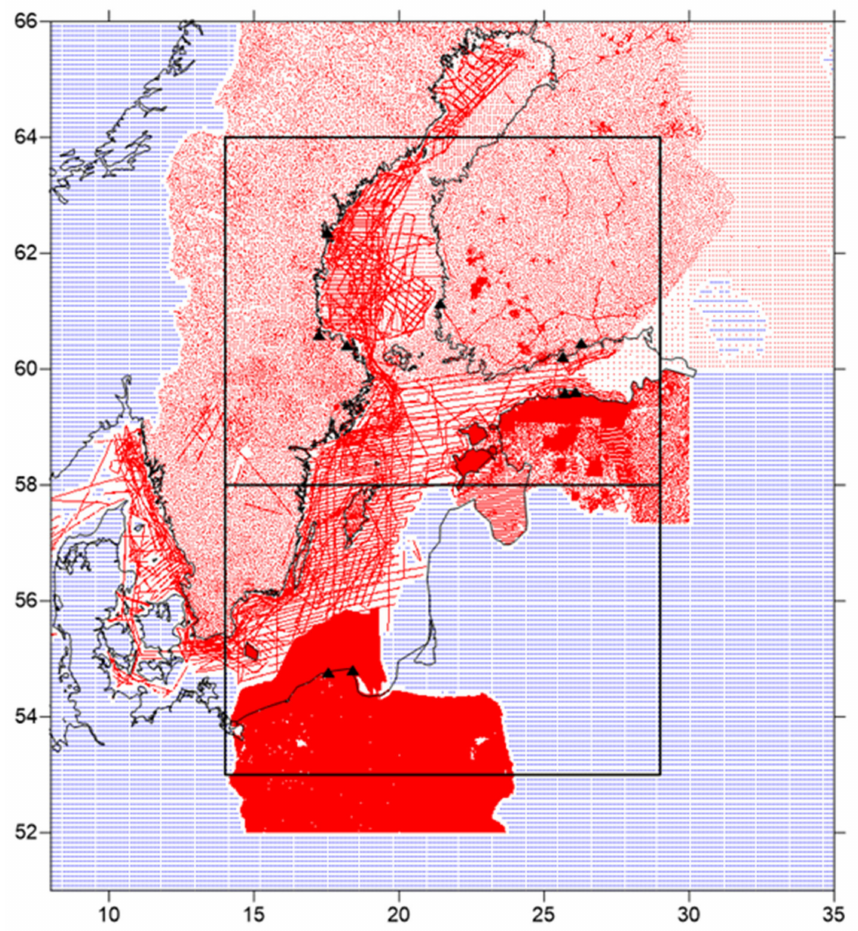
Figure 12. Gravity data selected to compute the gravimetric quasi-geoid models over the Baltic Sea test area. The data includes the gravity datasets of the NKG2015 project from Sweden, Finland, and Estonia (plus some other open datasets), new FAMOS marine gravity data from the same countries and the Polish gravity data currently in the NKG2015 gravity database. Pseudo-observations (5 (cid:48) × 5 (cid:48) ) generated by EIGEN-6C4 are plotted as triangles. The TG and ECR locations are plotted as black triangles. The locations of north and large quasi-geoid test areas are also